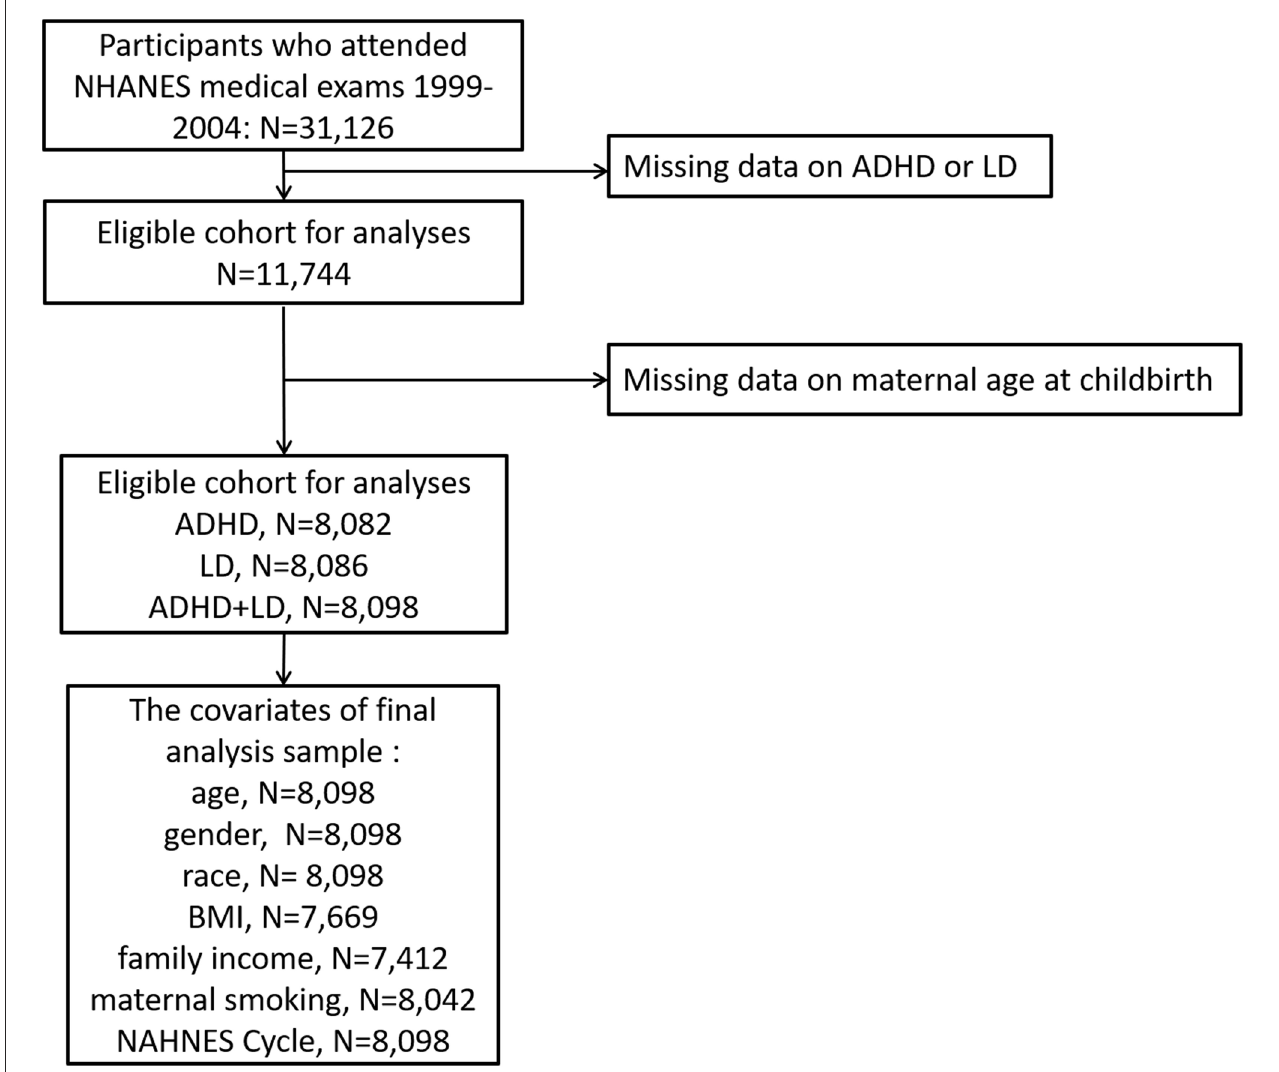
FIGURE1 Eligible participants and those included in the analyses of the associations between maternal age at childbirth and the risk of ADHD and LD in offspring in the U.S. population.